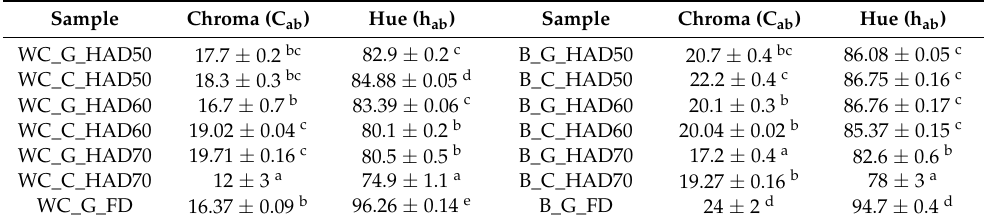
Figure 3. Distribution of L*a*b* coordinates of white cabbage and broccoli waste powders. WC: white cabbage; B: broccoli; G: ground; C: chopped; HAD: hot-air drying at 50, 60 and 70 °C, FD: freeze drying. Table 3. Colour parameters of white cabbage (WC) and broccoli (B) powders: chroma (C ab ) and hue (h ab ). HAD: hot-air drying at 50, 60 and 70 °C, FD: freeze drying; C: chopped; G: ground. Mean ± standard deviation of three replicates.